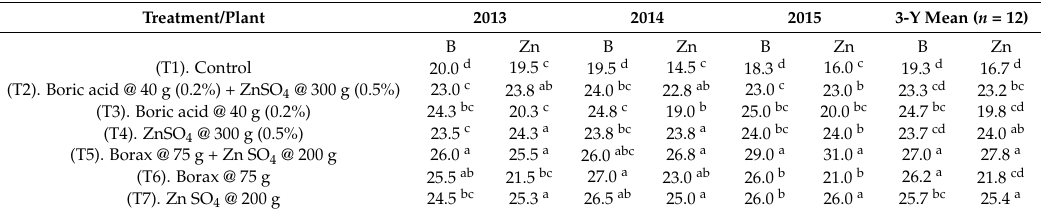
Table 3. Effect of experimental treatments on mean B and Zn concentrations (mg kg − 1 ) in mango leaves (cv. Chaunsa white) sampled in July (2013–2015) *.